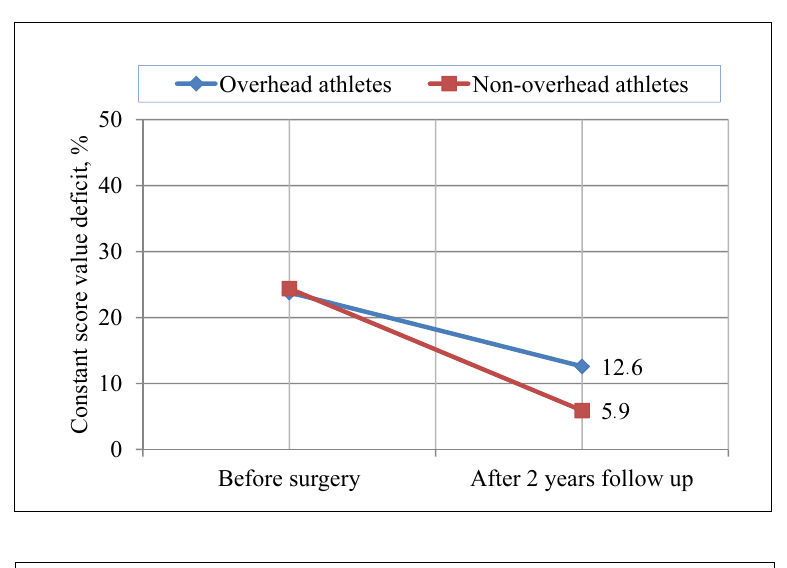
Figure 2. Shoulder range of motion in overhead and non-overhead athletes groups